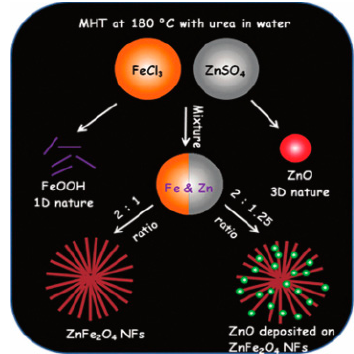
Figure 9. Pictorial presentation of the synthetic strategy of the as-synthesized materials at different reaction conditions